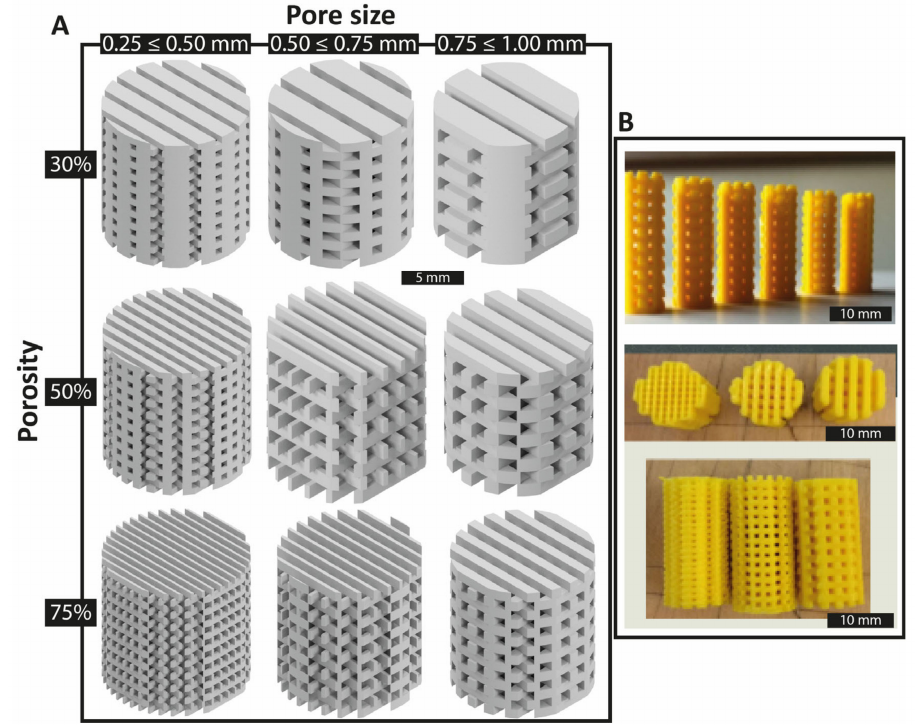
Figure 2. Scaffold test specimen geometries: specimens with different inner architectures were created due to the combinations between pore size and porosity. ( A ) Representative specimen design of 10 mm height with a H/D ratio of 1.0, is shown for the different combinations of porosity and pore size. ( B ) Actual printed samples based on ( A